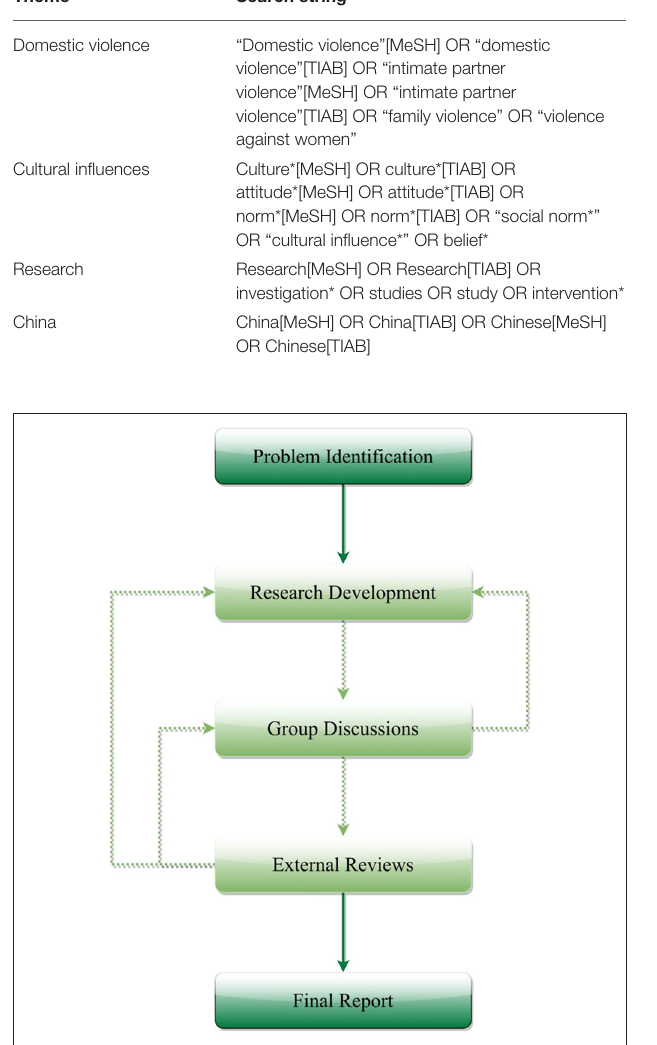
FIGURE 1 | A schematic representation of the research flow.